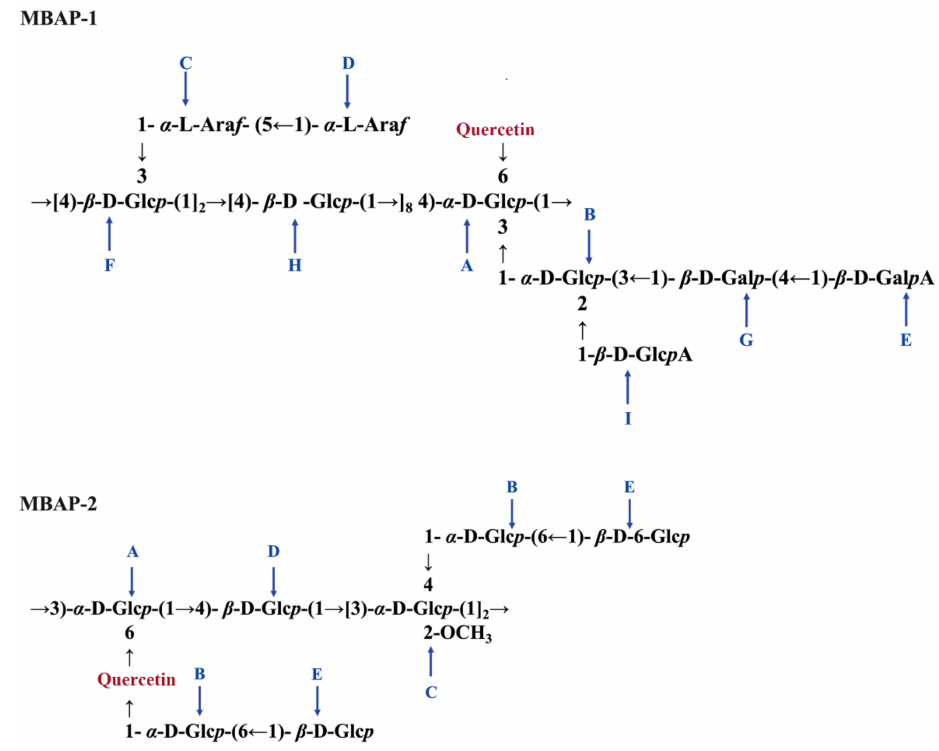
Figure 5. The putative structures of the repeating units of MBAP-1 and MBAP-2. The residues were labeled as A, B, C, D, E, F, G, H and